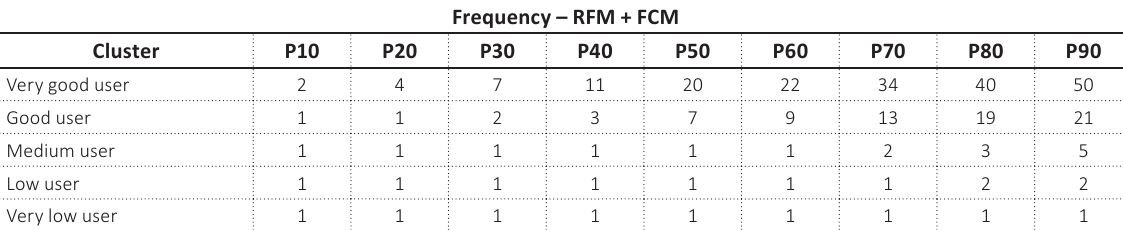
Table 5. Frequency